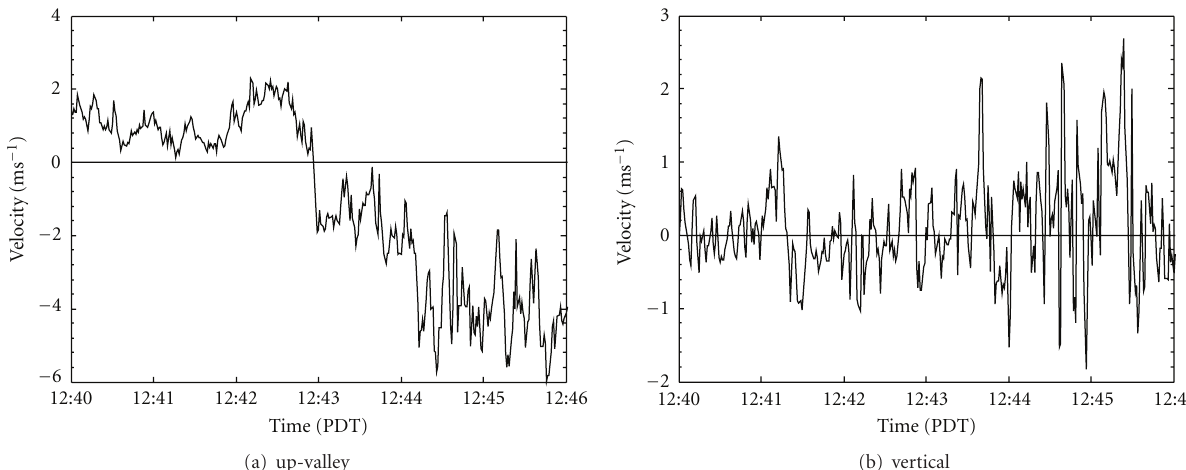
Figure 8: A time series of 1Hz (a) along valley and (b) vertical velocity, w , observed at the interior tower. Positive along-valley wind velocities in (a) indicate up-valley direction.